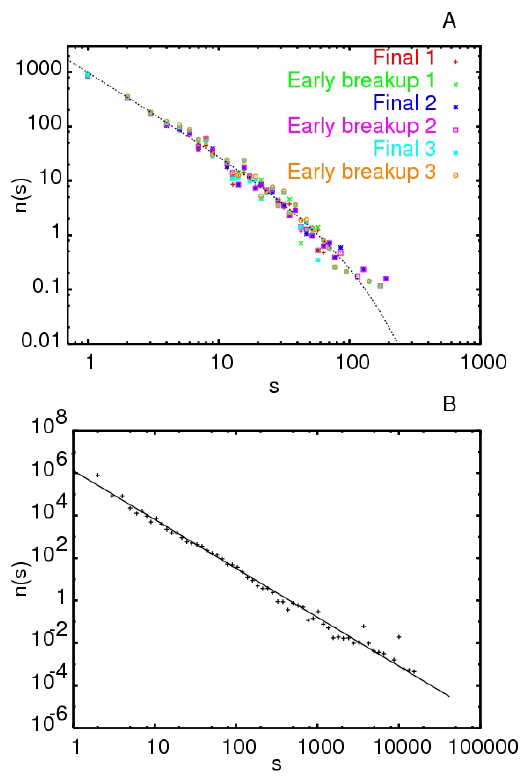
Fig. 4. (A) The fragment size distribution for simulations like the one in Fig. 3. The figure displays the results for three different sim- ulations and both the distribution early during the calving event and later when the fragments have come to rest floating on the water. The line is the distribution predicted from Eq. (3). (B) The fragment